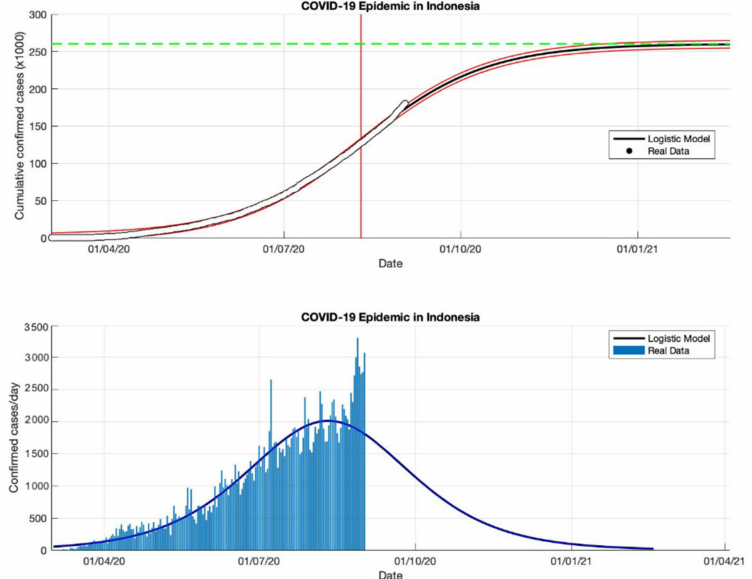
Figure 18. In the above figure, the prediction results of the logistic growth model for cumulative infected cases are compared with the actual data, while the two red lines between the black lines represent a prediction error limit of about 5%. The dashed green line predicts the total size of infected cases in the final phase of the epidemic. The red line intersects the cumulative case curve to predict the turning point or peak point of the epidemic (this line is parallel to the top of the curve from the below figure). In the below figure, the prediction results of this model for daily infected cases